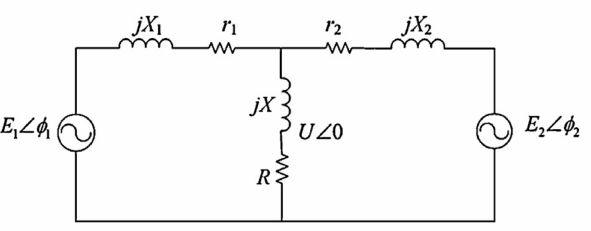
Figure 5. A simplified equivalent circuit of two DGs operating in